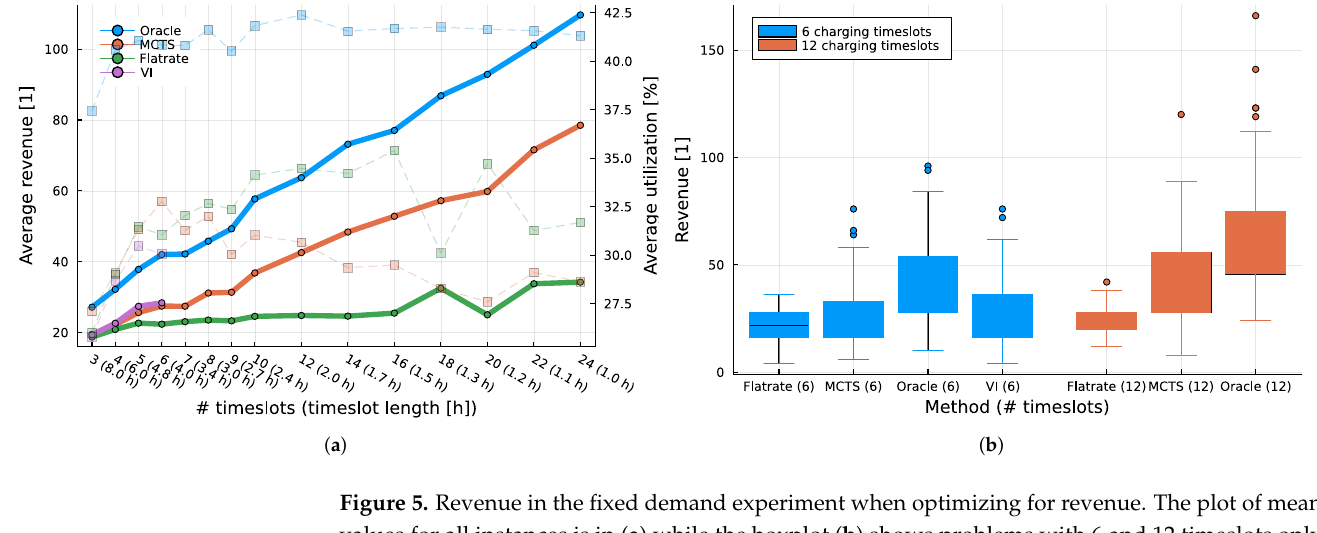
Figure 5. Revenue in the fixed demand experiment when optimizing for revenue. The plot of mean values for all instances is in ( a ) while the boxplot ( b ) shows problems with 6 and 12 timeslots only. The right-hand y-axis and thin plot lines in ( a ) show the utilization of each method (that was not the optimization criterion). In this experiment, we have fixed the expected number of charging hours while varying the number of timeslots in the 24 h selling period, K , across the different problem instances.